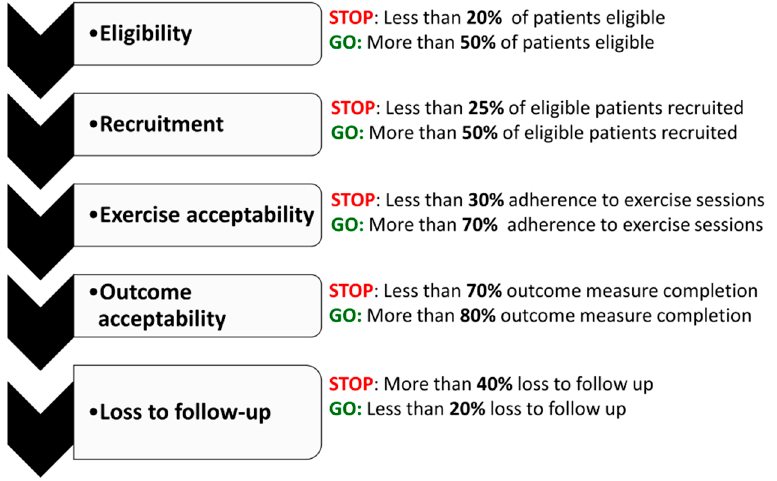
Figure 4. Final progression criteria developed for the FLEX-HD study.